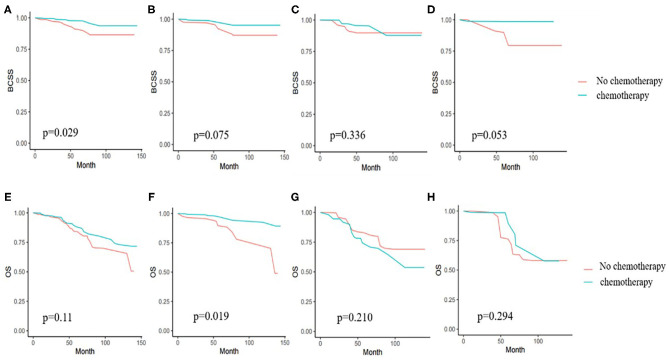
(A) Kaplan-Meier analyses of the effect of chemotherapy on breast cancer specific survival (BCSS) in weighted samples of all patients. (B) BCSS in patients with age from 70 to 74 years. (C) BCSS in patients with age from 75 to 79 years. (D) BCSS in patients age 80 years or older. (E) Kaplan-Meier analyses of the effect chemotherapy on overall survival (OS) in weighted samples. (F) OS in patients with age from 70 to 74 years. (G) OS in patients with age from 75 to 79 years. (H) OS in patients age 80 years or older.